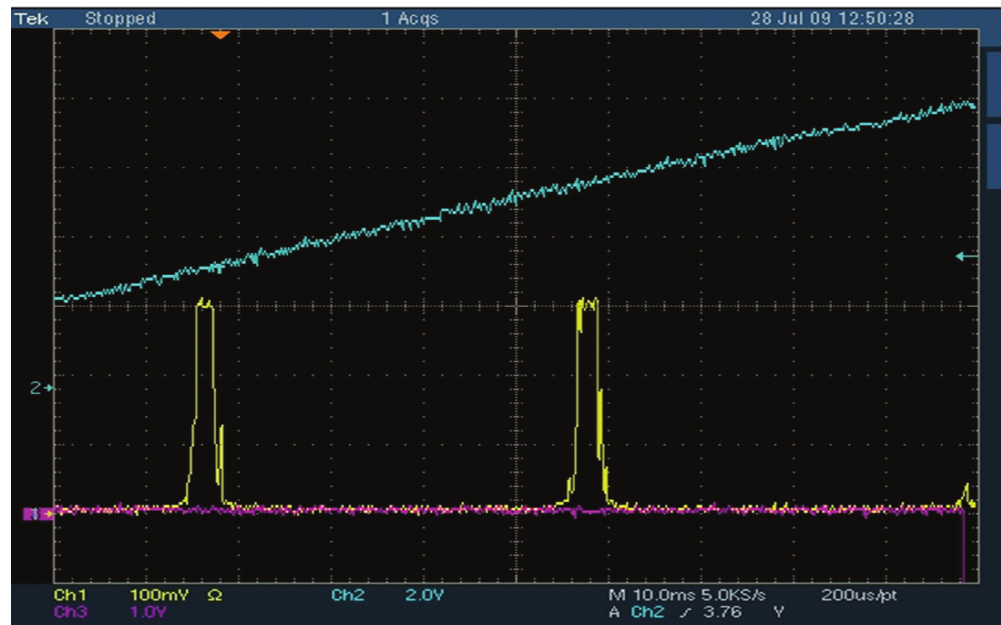
Figure 8: Output of the laser obtained using SFPSA when the laser operated in the pulsed